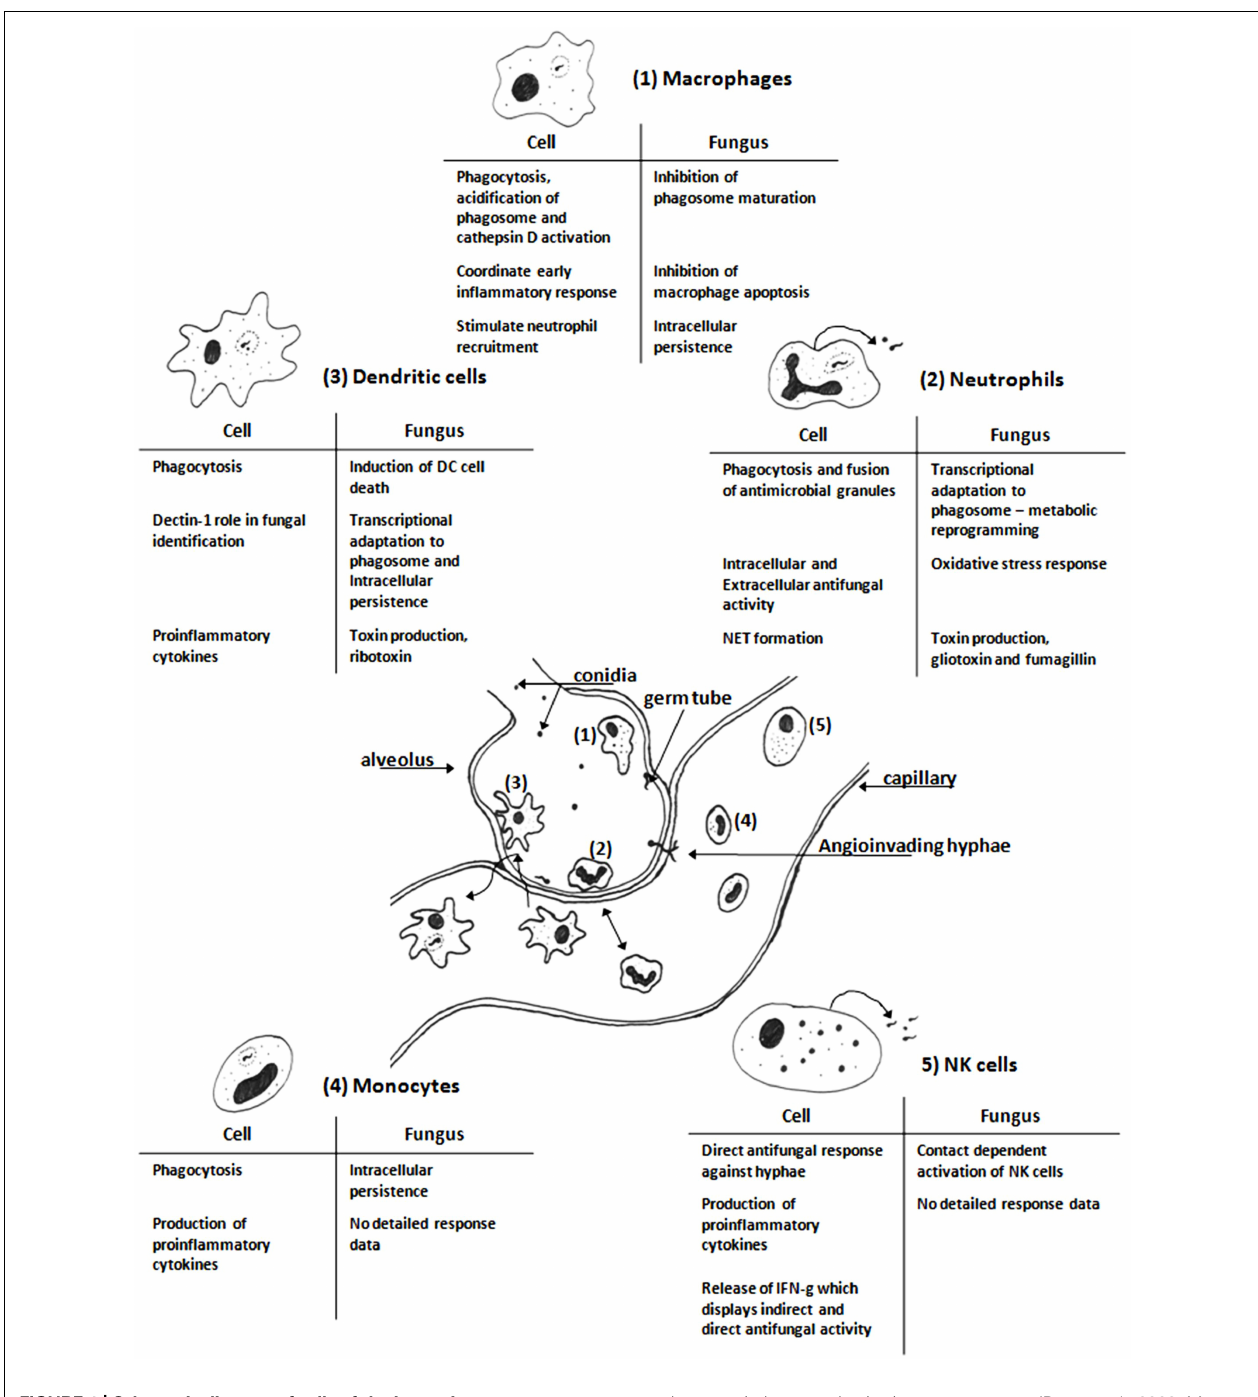
FIGURE 1 | Schematic diagram of cells of the innate immune system interacting with Aspergillus fumigatus in the vicinity of an alveolus. The resident alveolar macrophages (1) are first to encounter the fungus and after phagocytosis they kill the ingested fungus and initiate the inflammatory response (Segal, 2007;Volling etal., 2007; Slesiona etal., 2012). Neutrophils (2) are recruited to the site of infection by chemoattractant cytokines, they are necessary for clearance of the fungal infection (Sugui etal., 2008; Brakhage etal., 2010; Fallon etal., 2010). Dendritic cells (3) actively scan the body for potential infectious agents; they phagocytose pathogens and drain to the lymph nodes where they can present antigens from the degraded